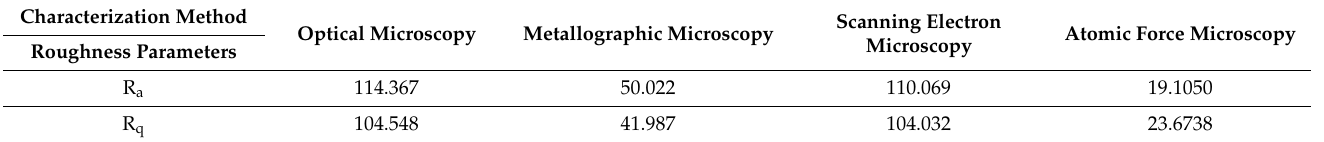
Table 2. Roughness parameters of DIO-NPs coating’s surface obtained from different characterization methods. Characterization Method